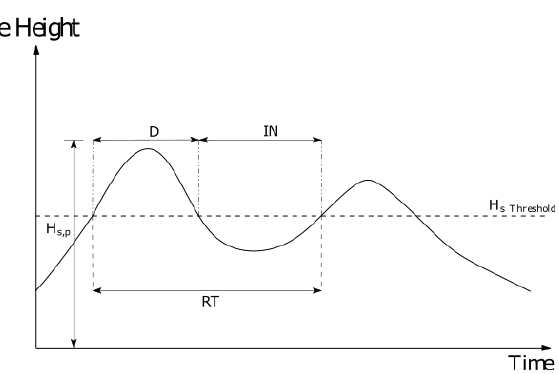
Figure 3. Storm event definition. D, duration; RT, repetition time; IN, interval.